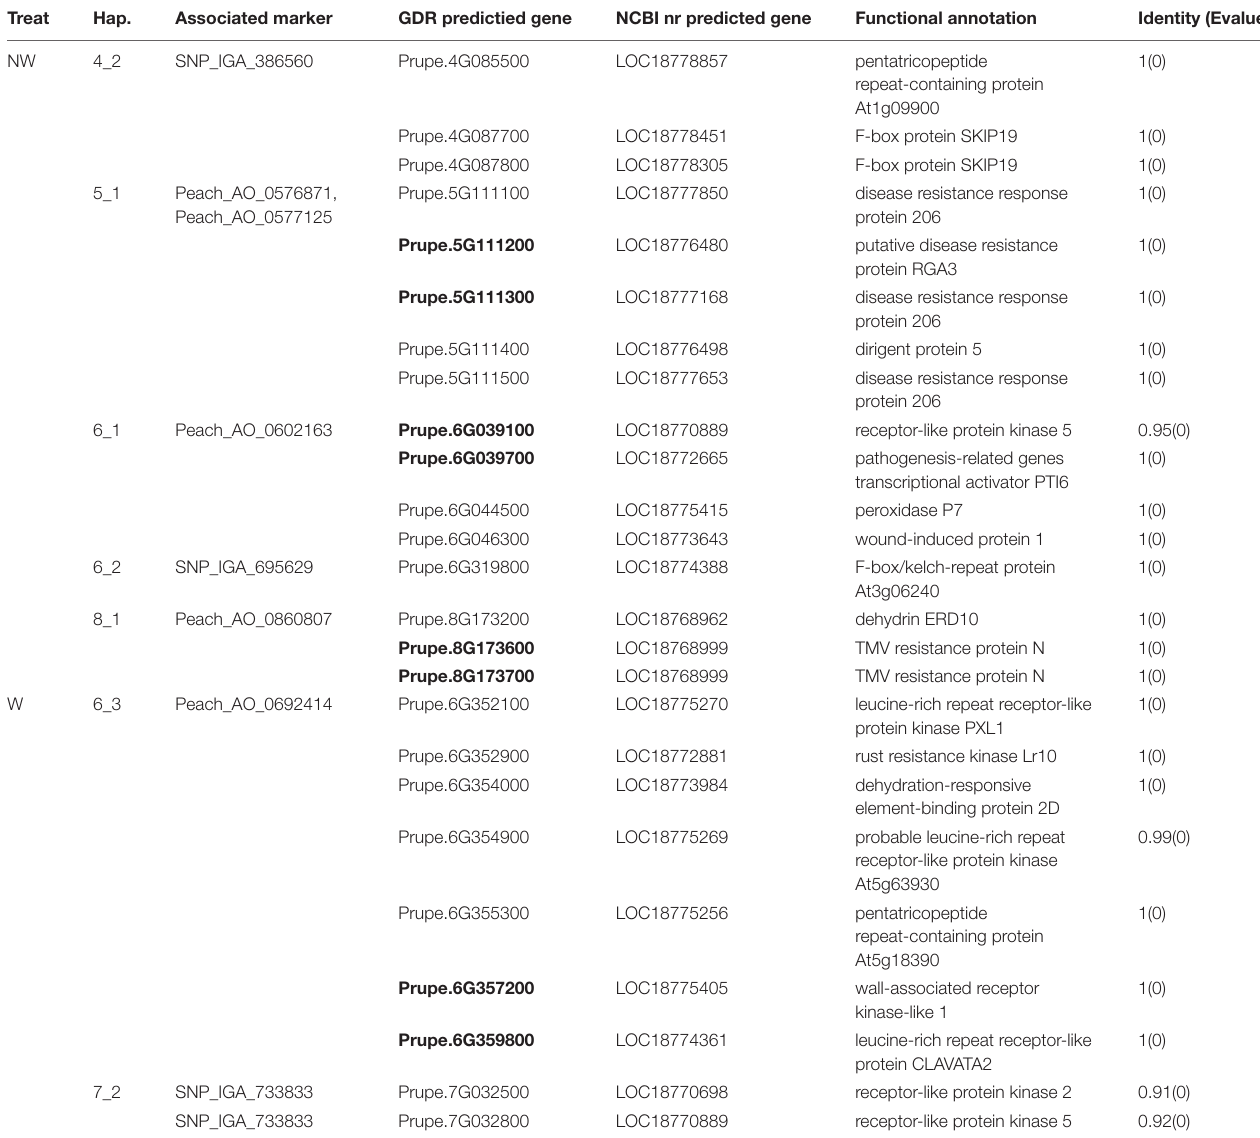
TABLE 5 | Peach genes detected in NCBI nr. Treat